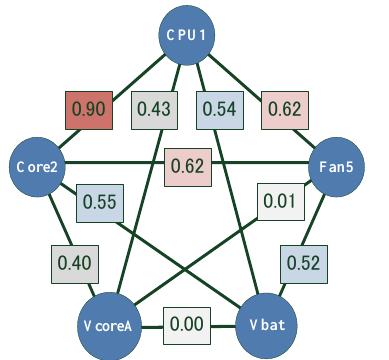
Figure 2. Correlation coefficients among five sensors.